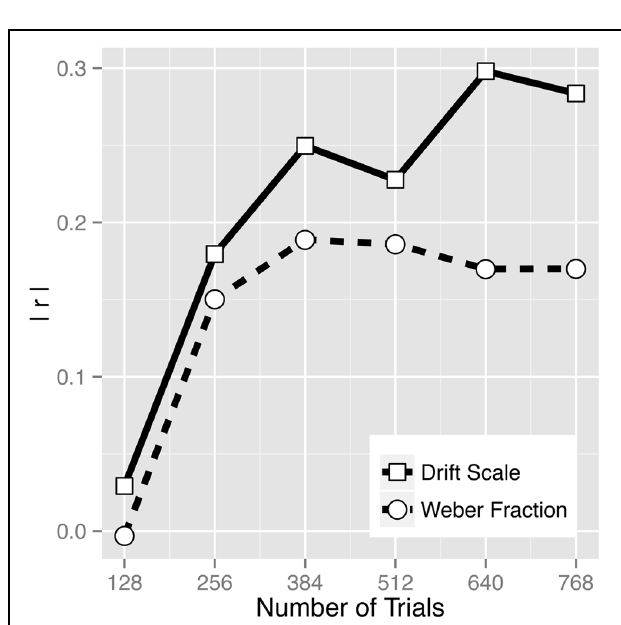
FIGURE 6 | Absolute value of the correlation coefficients between drift scale ( v s ) and math score and between Weber fraction ( w ) and math score as a function of number of